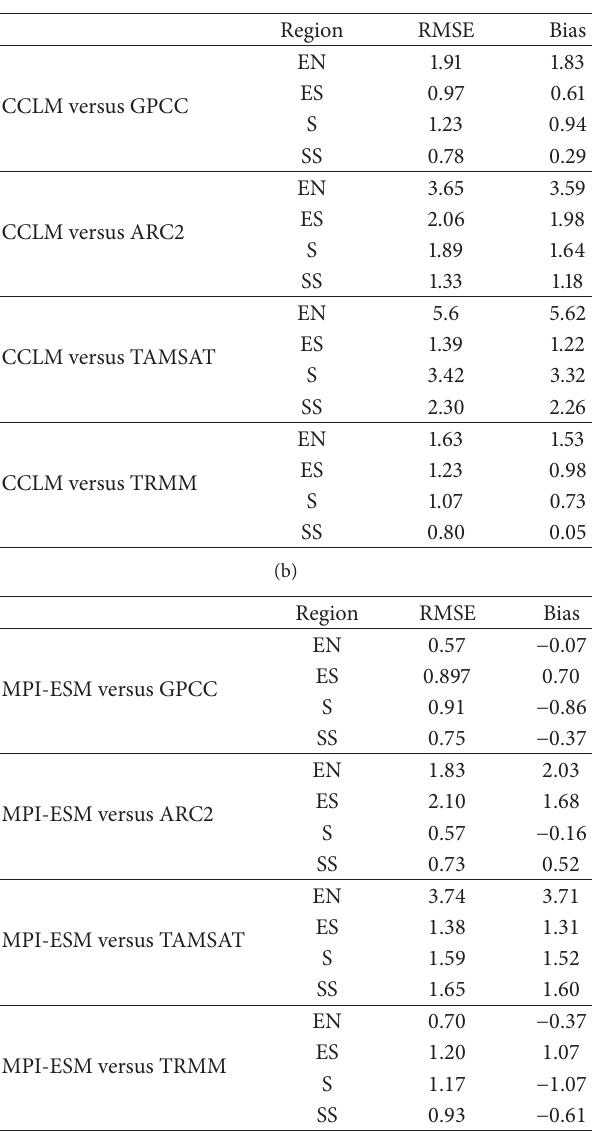
Table 2: RMSE and mean difference (bias) of JJAS daily precip- itation (mm/d) averaged over the four regions for COSMO-CLM (CCLM, (a)) and MPI-ESM